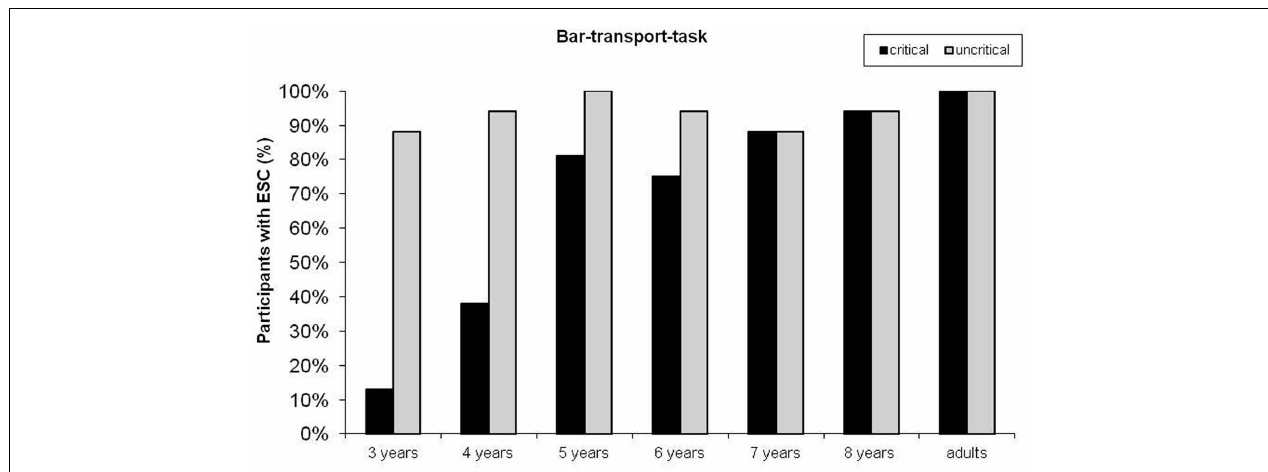
FIGURE 2 | Percentages of participants showing the end-state comfort effect (ESC) in critical and uncritical trials across age in the bar-transport task.